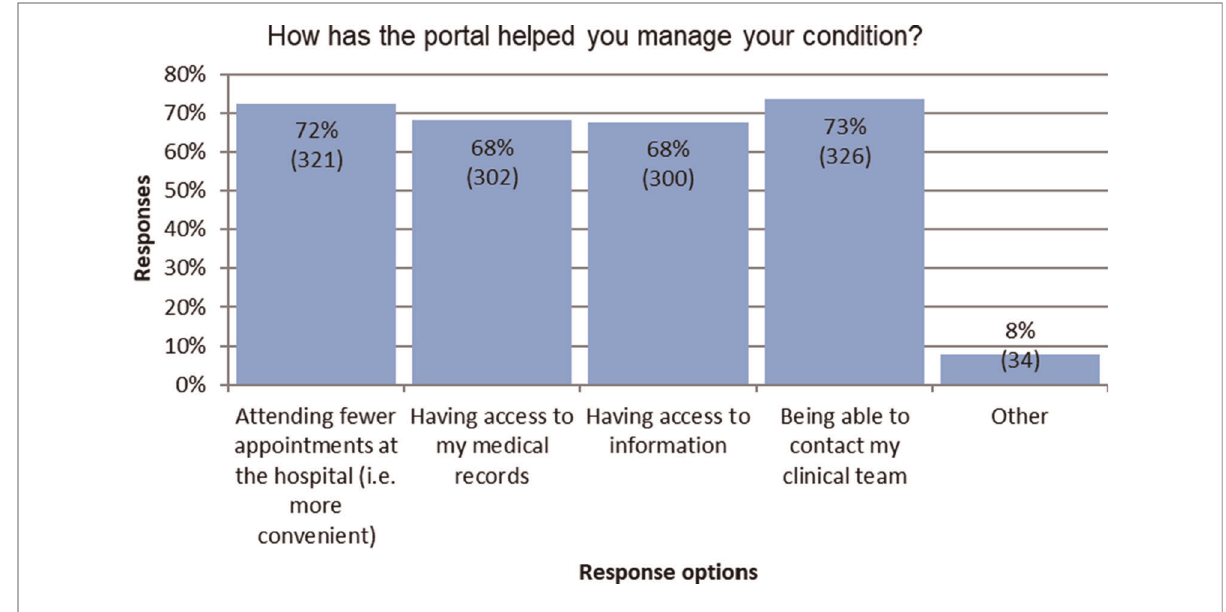
FIGURE 4 Ways the portal helped users their